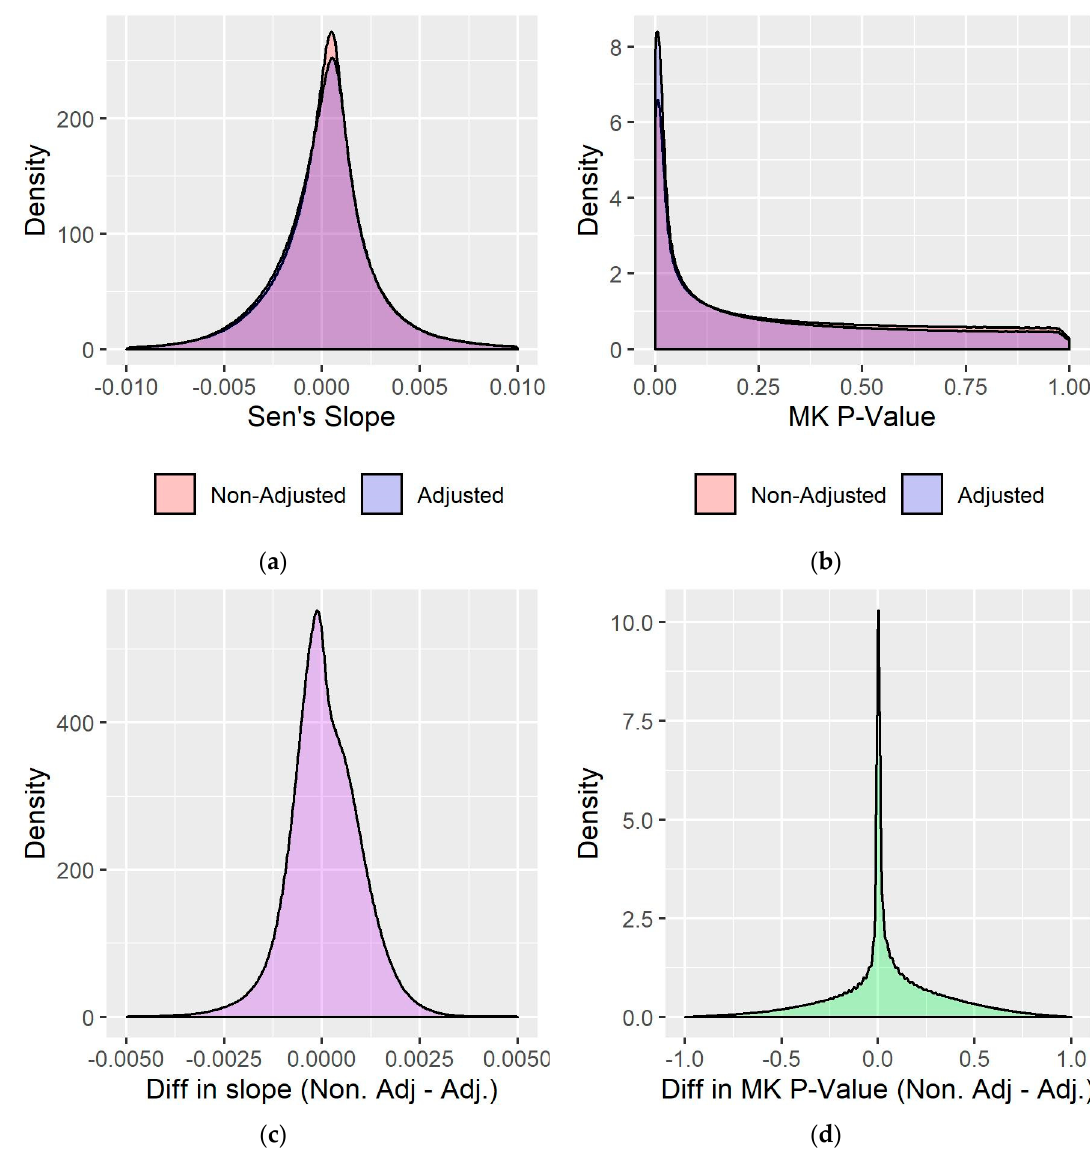
Figure 7. Distributions ( a , b ) and differences ( c , d ) of original vs. drought-adjusted NDVI Sen;s slopes ( a , c ) and Mann Kendall (MK) test P-values ( b , d ).